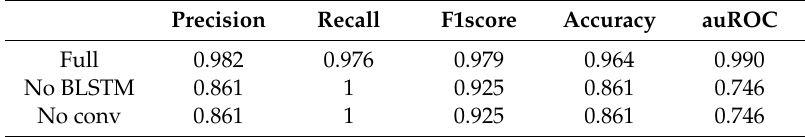
Table 5. Classification performance of two variant deep learning architectures and our original